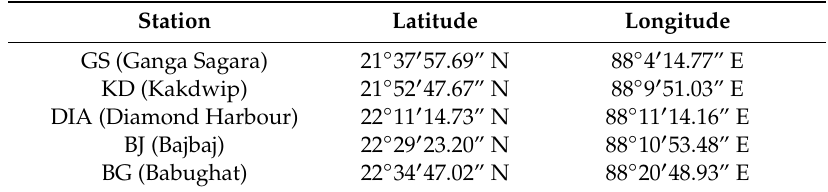
Table 1. Latitude and longitude values for the stations selected in this study and where sediments were